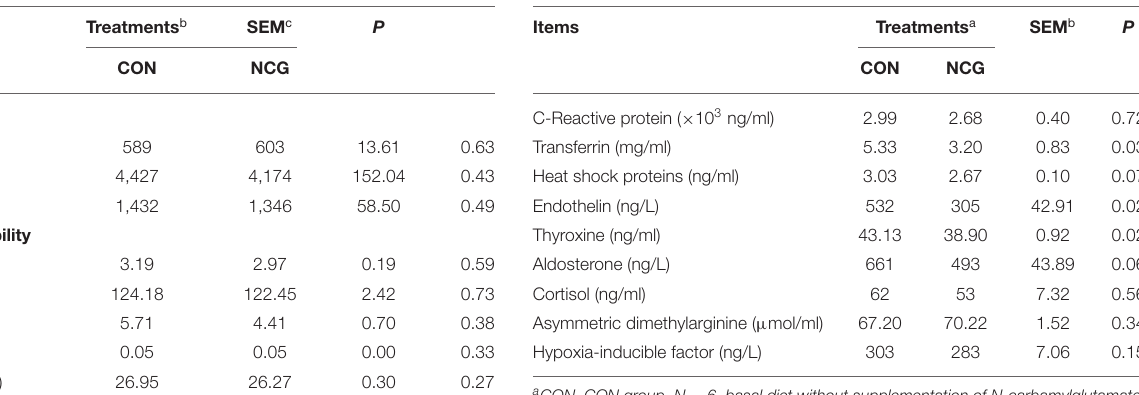
TABLE 5 | Effect of NCG on plasma immunity and antioxidant parameters of experimental Jersey cattle.